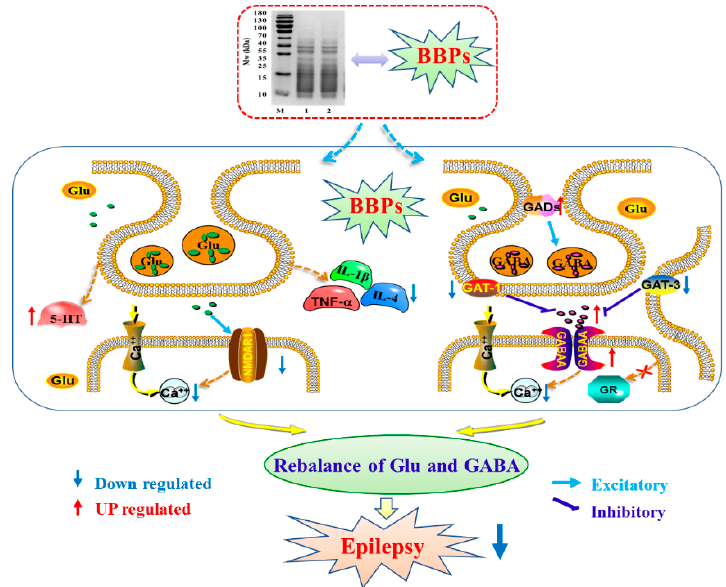
Figure 6. Molecular mechanism of BBPs on epilepsy. BBPs: protein extracts in Bombyx batryticatus .